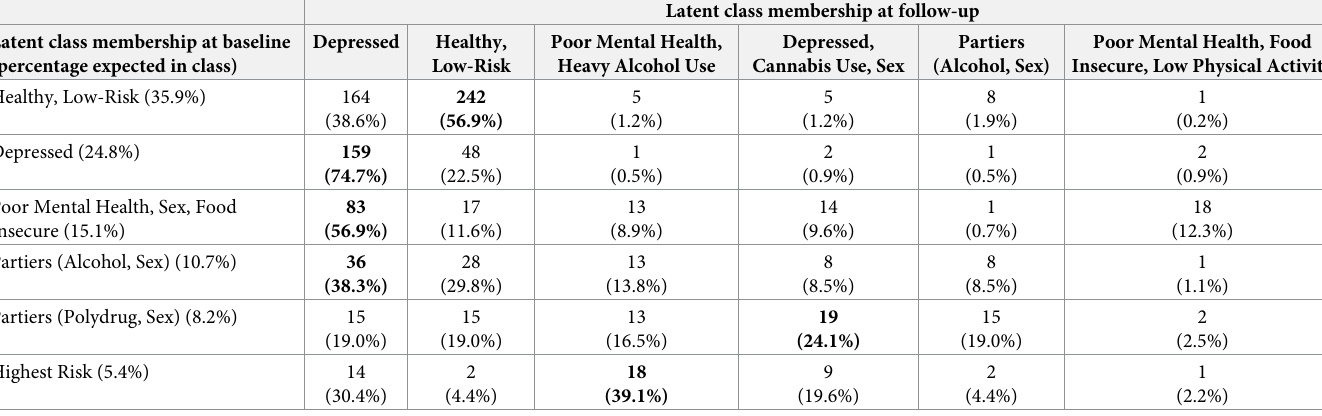
Table 5. Approximate cell counts and probabilities of membership in health and well-being class at follow-up conditional on baseline class membership. Latent class membership at